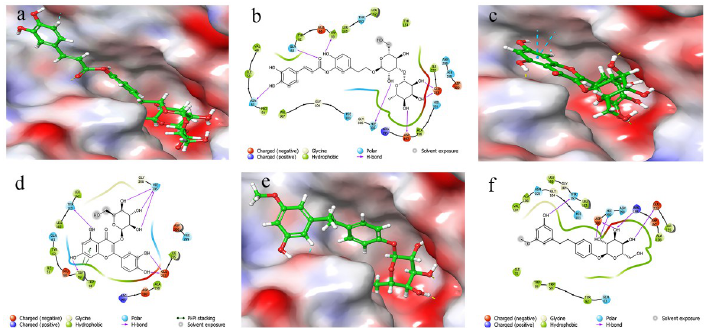
Fig 2. Docked poses and molecular interactions of HPA with inhibitors: 3D molecular surface diagrams and 2D ligand interactions of newboulaside A (a) and (b), quercetin-3-O- β -glucoside (c) and (d), and sasastilboside A (e) and (f), respectively. The hydrogen bonds are represented as pink